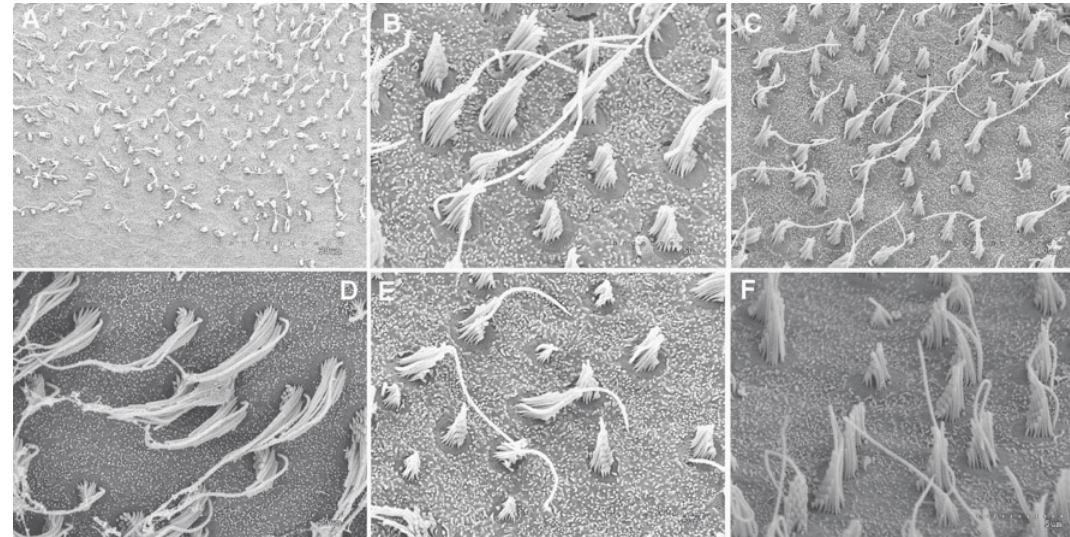
Figure 8. SEM (scanning electron microscopy). Lagena sensory epithelium. ( A , B ) Exposed animals. Control. ( C – F ) By comparison with control animals, the images of the saccule epithelium show healthy sensory hair cells in all cases of exposed animals (1 week ( C ), 2 weeks ( D ), 3 weeks ( E ) and 4 weeks ( F ) of sound exposure). Scale bar: ( A ) = 30 µm. ( C , D ) = 10 µm. ( B , E , F ) = 5 µm.